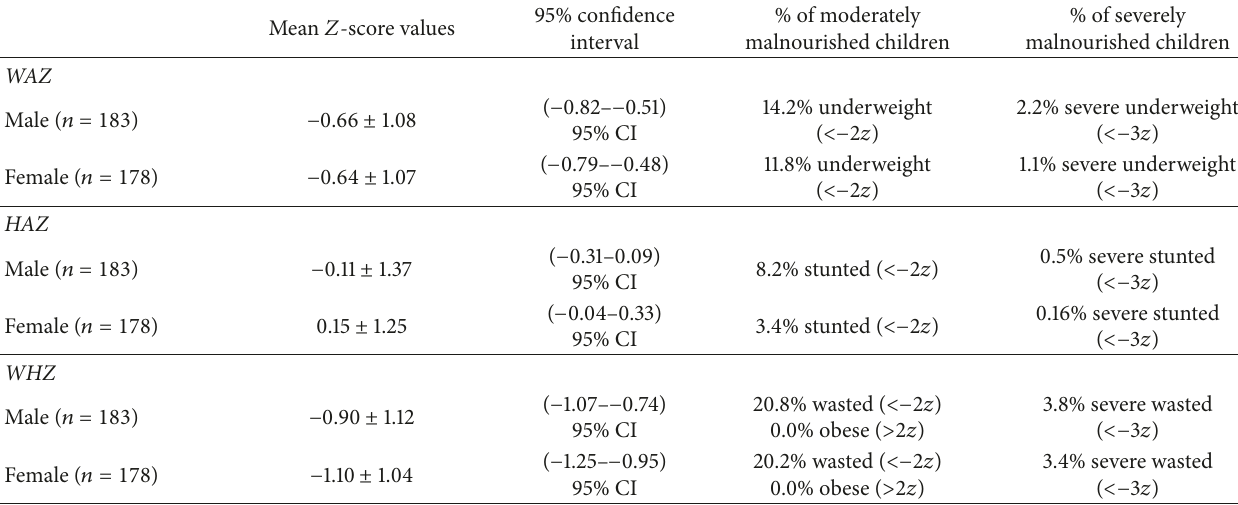
Table 6: Prevalence of malnutrition in PSAC in Mwea Division based on the children’s 𝑍 -scores.